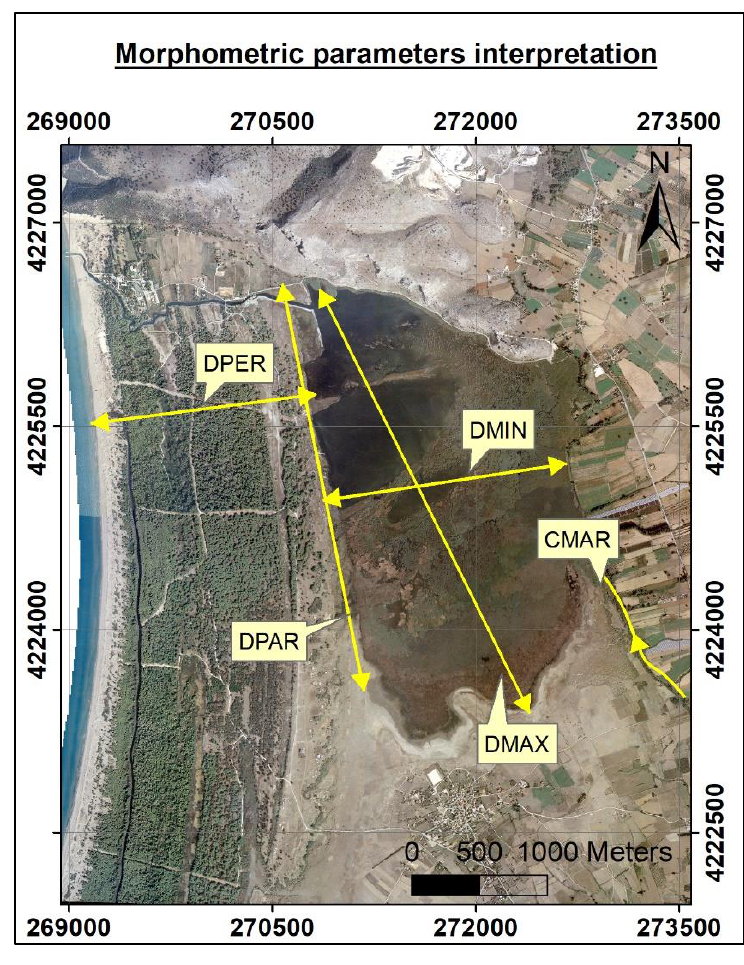
Figure 3. Prokopos Lagoon morphometric parameters interpretation.